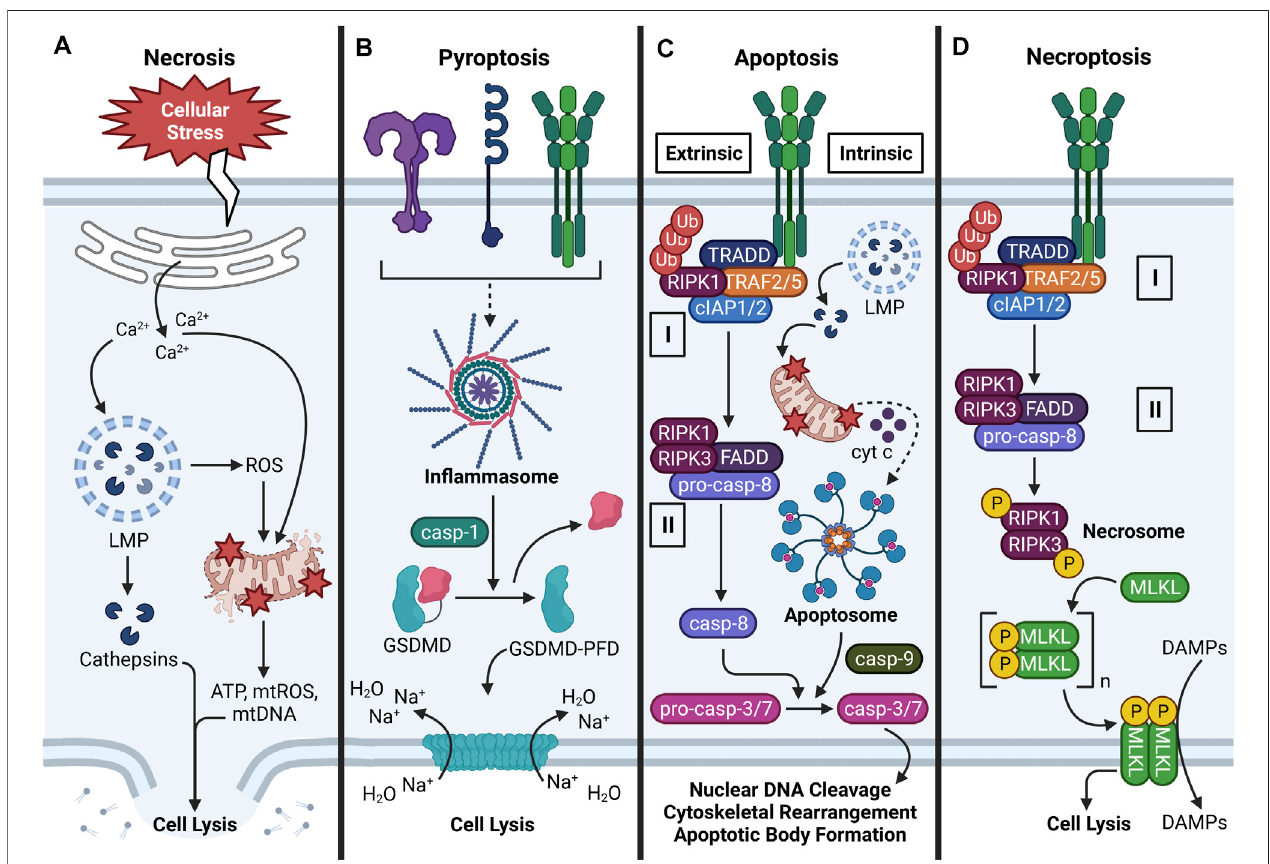
FIGURE 4 | Major cell death pathways induced by particles. (A) Overview of necrosis. Necrosis can be triggered by various stimuli that provoke cellular stress. Common hallmarks of necrosis include Ca 2+ ef fl ux from the ER, Ca 2+ -induced LMP and cathepsin release, ROS-driven mitochondrial dysfunction, cellular swelling, plasma membrane rupture, and DAMP release. (B) Overview of pyroptosis. Following NLRP3 in fl ammasome oligomerization and activation, caspase-1 proteolytically processesGSDMDtoexposeitsN-terminalpore-formingdomain(PFD).GSDMD-PFDpolymerizesintoaporeintheplasmamembrane,whichallowsNa + tomove alongitselectrochemicalgradientintothecell.Byosmosis,waterentersthecell,causescellularswelling,andcelllysis. (C) Overviewofapoptosis(extrinsicandintrinsic). Extrinsicapoptosisistriggeredbyactivationofadeathreceptor(e.g.,TNFR),whichpromotesassemblyofComplexI.ComplexIconsistsofTRADD,TRAF2/5,cIAP1/2, andubiquitinatedRIPK1.InhibitionofcIAP1/2and/ordeubiquitylationofRIPK1byCYLD(notshown)inducesformationofcytosolicComplexII,whichconsistsofRIPK1, RIPK3, FADD, and pro-caspase-8 oligomers that proteolytically activate themselves. Intrinsic apoptosis is de fi ned by release of cytochrome c (cyt c ) from perturbed mitochondria, formation of a multiprotein apoptosome, and activation of caspase-9. In certain cases, LMP-driven cathepsin release may contribute to mitochondrial dysfunction.Caspase-8/9proteolyticallyactivates caspase-3/7,whichpromotesnuclear DNAcleavage,cytoskeletalrearrangement,and apoptotic bodyformation. (D) Overview of necroptosis. Necroptosis is characterized by activation of a death receptor (e.g., TNFR), Complex I formation, and Complex II formation as in extrinsic apoptosis.Inhibitionofpro-caspase-8activationallowsformationoftheRIPK1-RIPK3necrosome,whichphosphorylatesMLKL.Phospho-MLKLmonomerspolymerize into a pore-shaped complex at phosphatidylinositol 3-phosphate sites in the inner lea fl et of the plasma membrane. Consequently, cell lysis occurs and DAMPs are released from the cell. Some steps in the depicted cell death pathways are omitted for